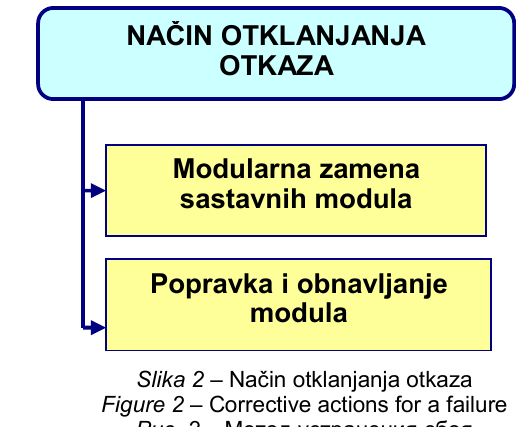
Figure 2 – Corrective actions for a failure Рис . 2 – Метод устранения